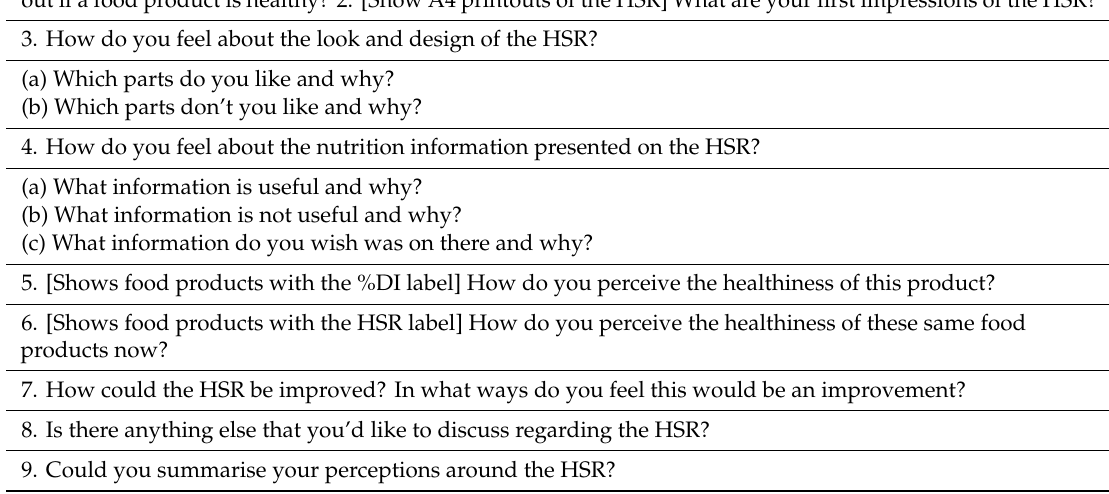
Table 1. Questions from the focus group questionnaire on the Health Star